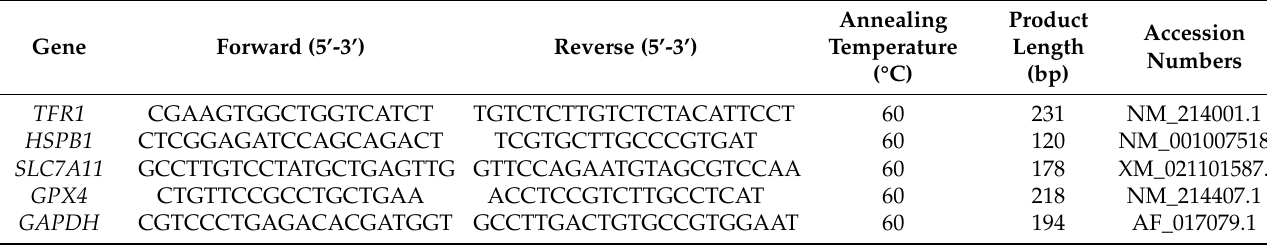
Table 1. Primer sequences used for real-time